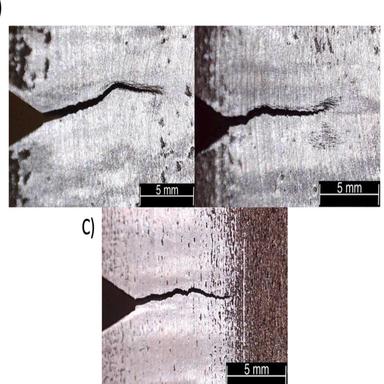
Fatigue crack profile of samples A) 0◦, B) 45◦ and C) 90◦.